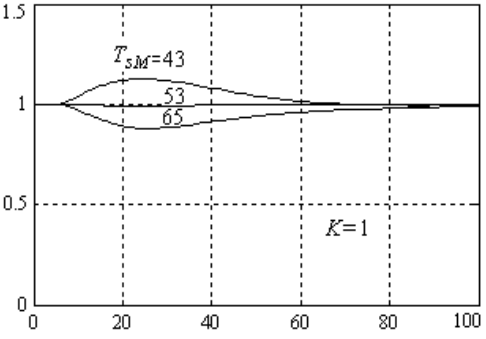
Figure 8. Control responses c ( t ) to a unit step setpoint for K M = 1, τ M = 5 and various T sM . With regard to the closed-loop responses c ( t ) to a unit step setpoint in the case K = 1, the following observations are valid for compensated processes of minimum phase and without